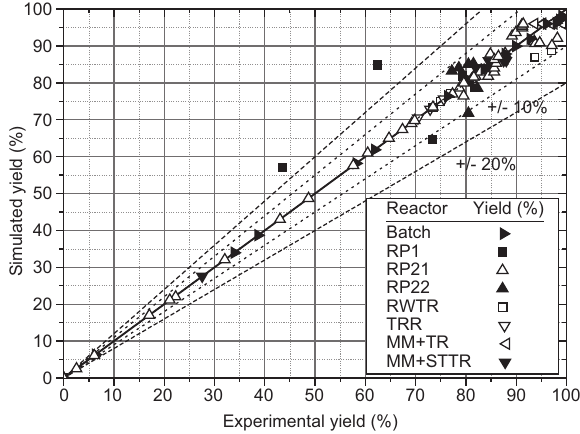
Figure 3. All the obtained parameters are reported in Table 3 , where are compared with the same parameters obtained for a stirred batch reactor [10] . It is interesting to observe = k × a for that, by assuming the interfacial area constant, γ 1 1 the MM + TR is 2.6 times greater than the value obtained in the batch reactor. The same difference has not been = k × a, because in the continuous reac- observed for the β C l tor a chemical regime is operative. As the comparison has been made at the same temperature, this difference can be ascribed only to the interfacial area difference in the two different reaction conditions. In the stirred batch reactors, the liquid-liquid interfacial area increases with the stir- ring rate as a consequence of the new generated smaller droplets, but stirring also favors the droplets agglomera- tion and the interface area increases until a maximum is reached when the two mentioned effects are balanced.